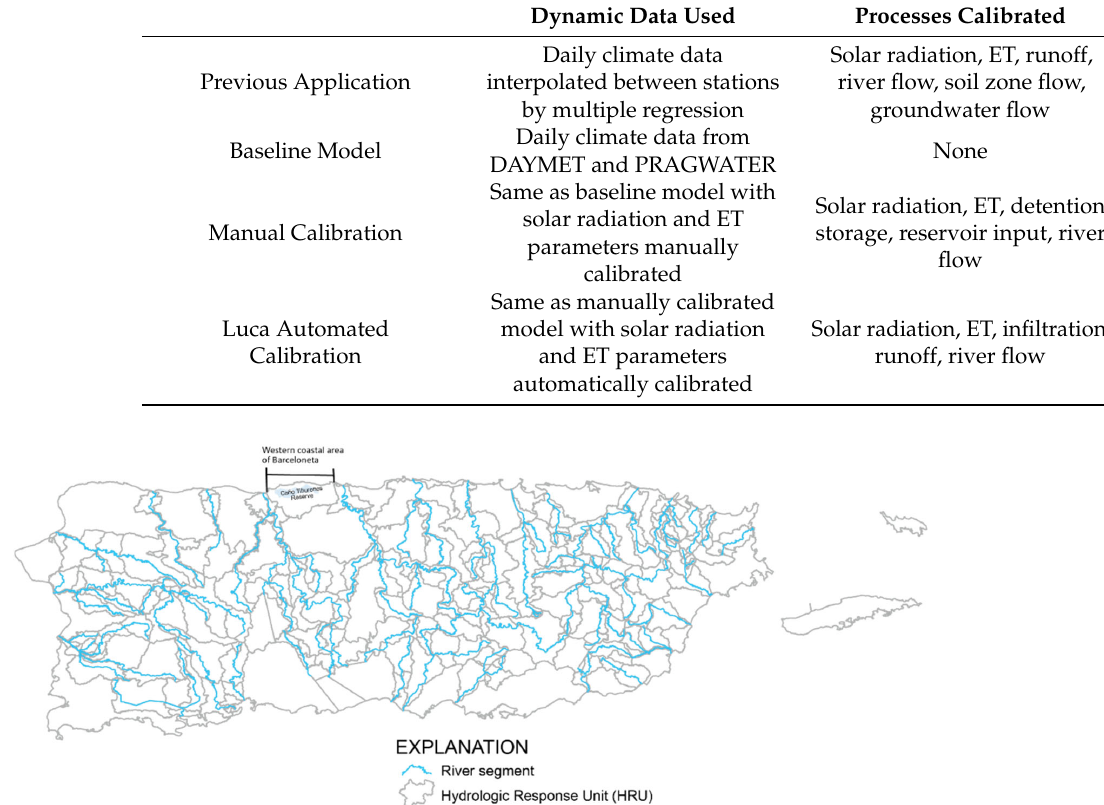
Table 1. Precipitation-Runoff Modeling System (PRMS) model development sequence; ET: Evapo-